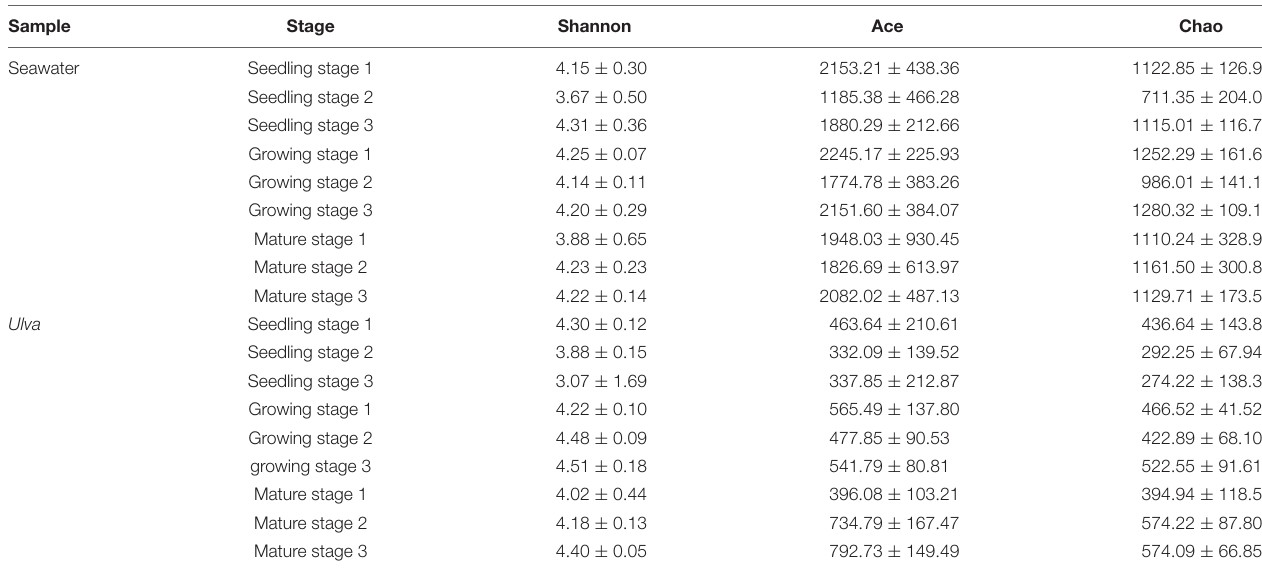
TABLE 1 | Microbiodiversity indices of U. fasciata surface and seawater at different growth stages.